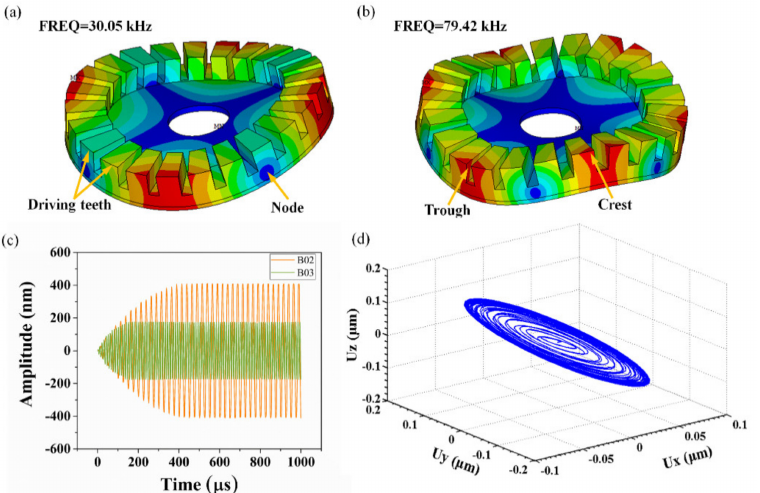
Figure 5. ( a , b ) Mode shapes simulated at resonant frequencies of 30.05 kHz and 79.42 kHz; ( c ) Amplitude-time curve in transient dynamic analysis at vertical Z direction; ( d ) Ellipse motion trajectory of one surface particle in three-dimensional